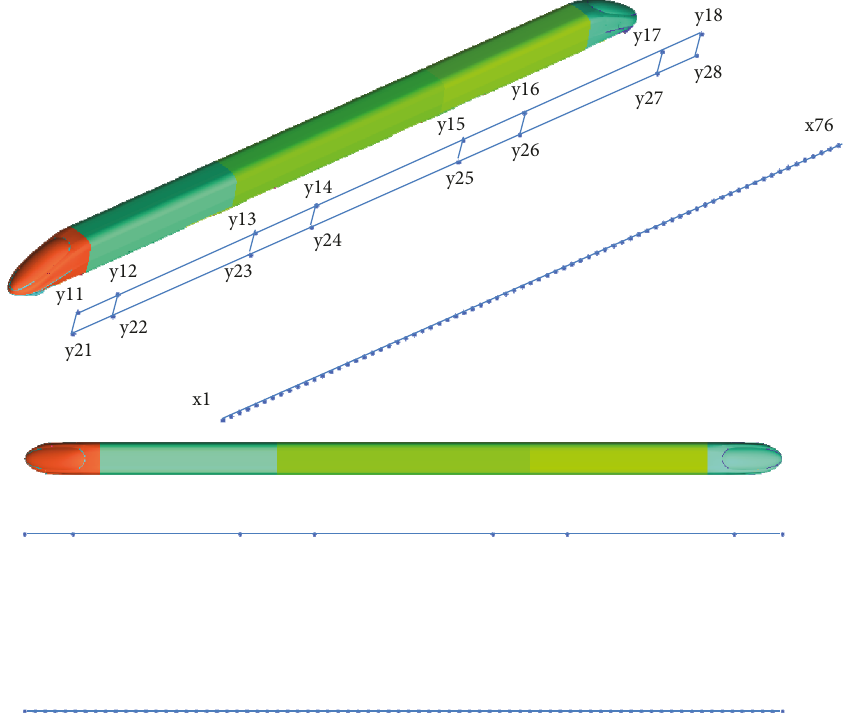
Figure 13: Distribution of noise points of bionic trains in far- fi eld.